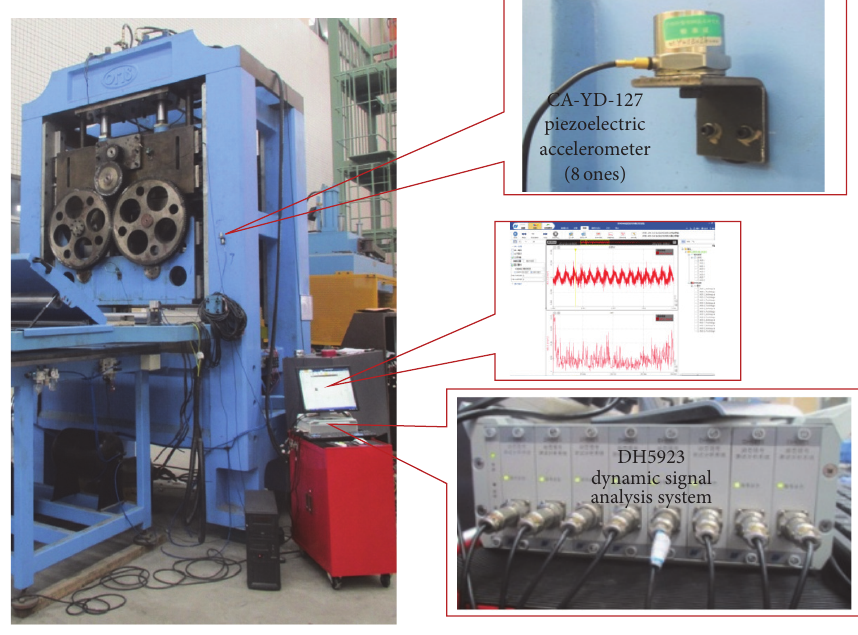
Figure 12: Experimental measurements of the acceleration of main components.